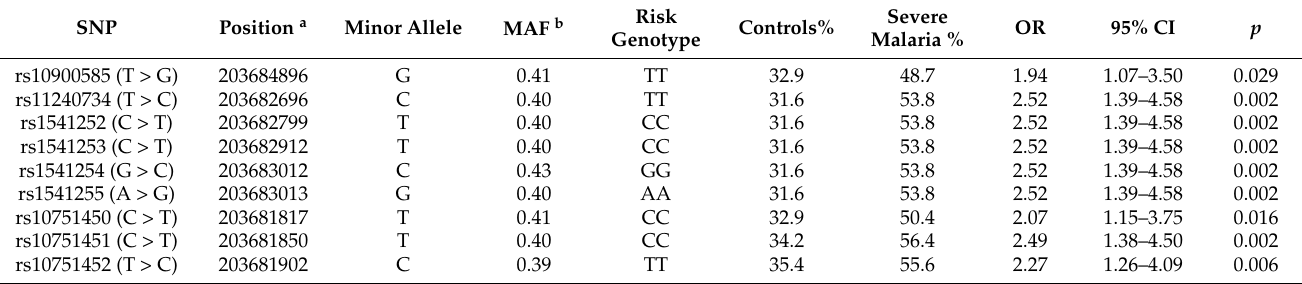
Table 2. Association of ATP2B4 SNPs with severe malaria in the Senegalese population-based study.